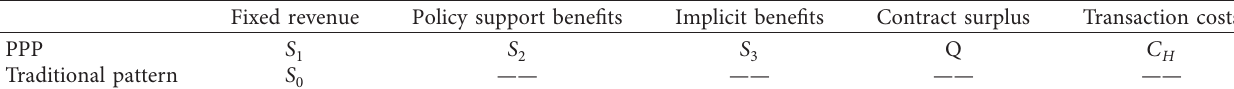
Table 4: Benefit parameters and cost parameters for social capital under two